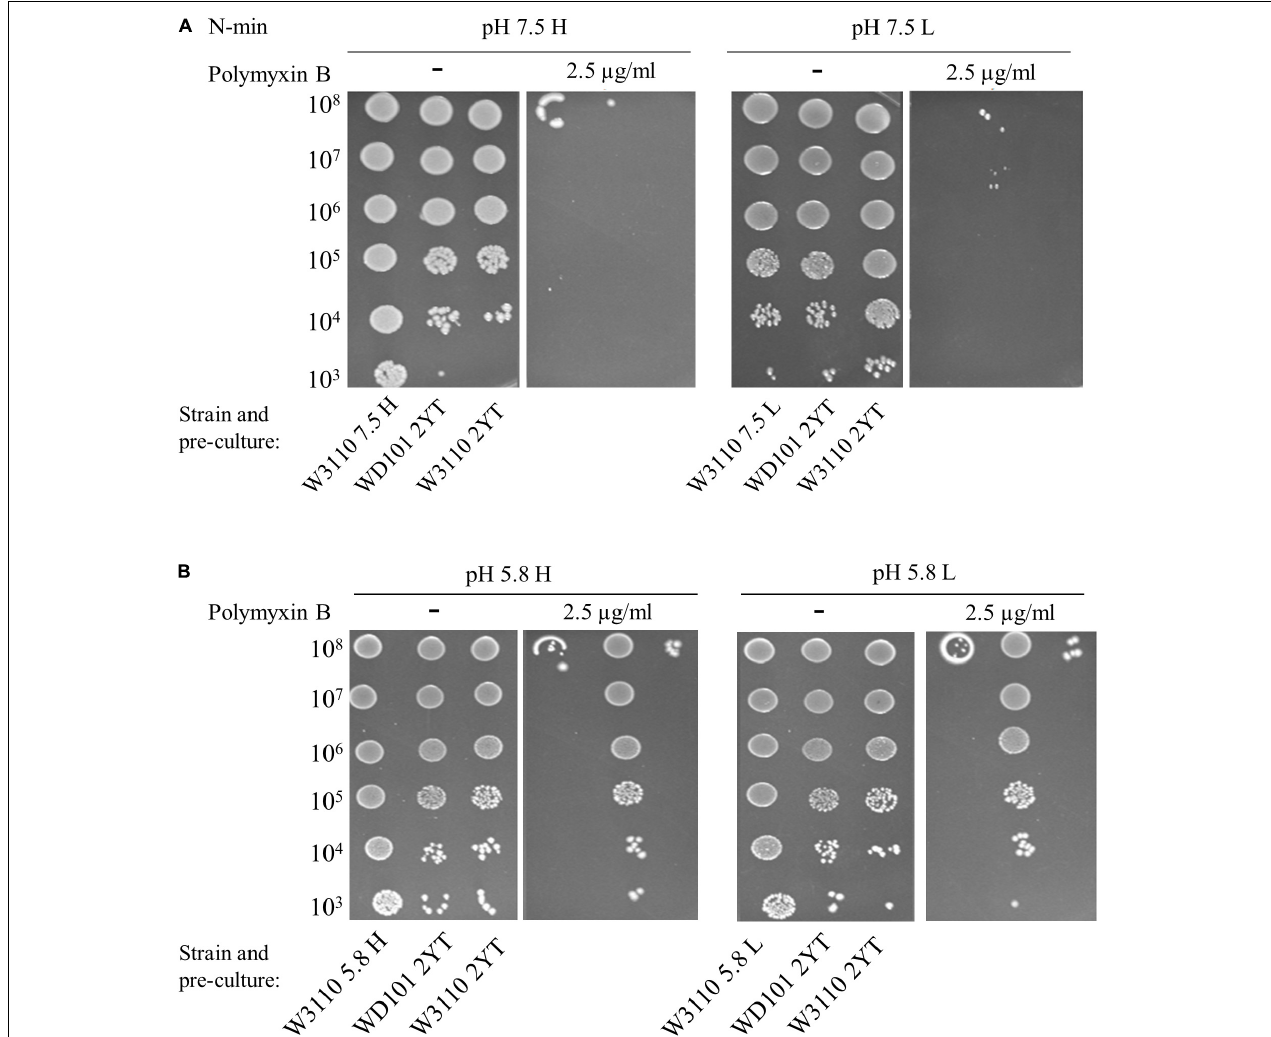
FIGURE 2 | Low Mg 2 + and low pH do not elicit polymyxin B resistance. W3110 and WD101 stains were grown in 2YT medium or minimal medium (N-min) at pH 7.5 (A) or 5.8 (B) with 1 mM (H = high, left) or 10 µ M (L = low, right) MgCl 2 . 5- µ l spots of dilutions of these overnight pre-cultures were then deposited on plates supplemented or not with 2.5 µ g/ml of polymyxin B as follows: (A) N-min at pH 7.5 with 1 mM (H) or 10 µ M (L) MgCl 2 . (B) N-min at pH 5.8 with 1 mM (H) or 10 µ M (L)